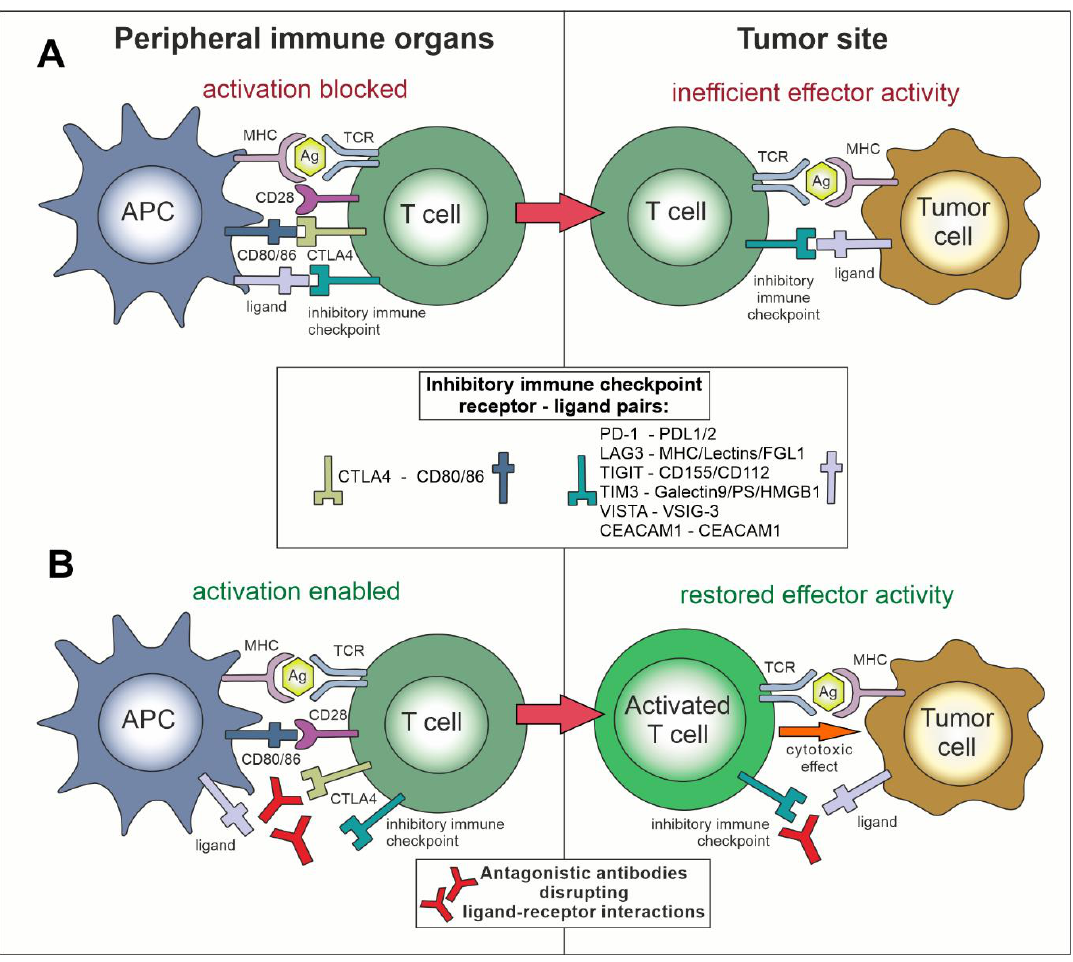
Figure 1. Targeting the negative immune checkpoints with monoclonal antibodies. ( A) The mechanism of actions of negative immune checkpoints on the example of a T cell. CTLA-4 binds to CD80 and CD86 receptors on the antigen-presenting cells (APCs), outcompeting immuno-stimulatory CD28 binding, and thus dampening the T cell receptor (TCR) signaling. Additionally, some other ligands for inhibitory immune checkpoints on immune cells may be expressed on APCs, and most of them can be overexpressed on tumor cells and/or in tumor microenvironment. Interactions between inhibitory immune checkpoints and their ligands block the activation of immune effector cells and prevent their cytotoxic response towards tumor cells. ( B) Application of antibodies antagonistic towards the negative immune checkpoint receptors and/or their ligands enables CD80/86 and CD28 immuno-stimulatory signaling and blocks immuno-inhibitory signaling through other negative immune checkpoints. Activated T cells can become capable of overcoming the regulatory mechanisms and elimination of the tumor cells.